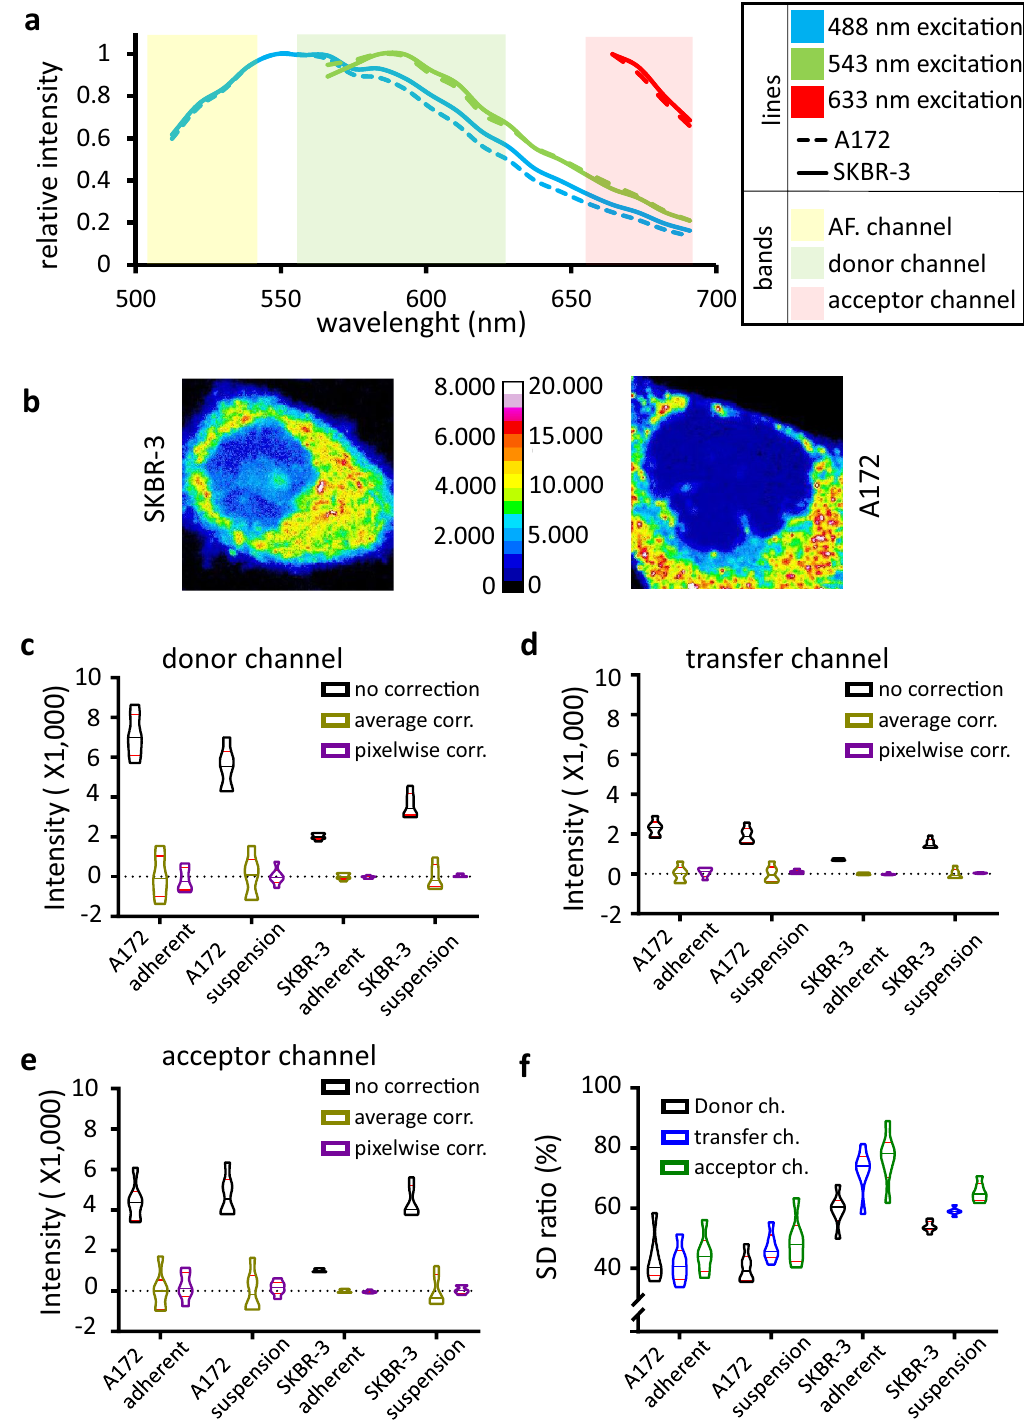
Figure 1. Characterization of cellular autofluorescence and different autofluorescence correction methods. ( a ) Autofluorescence emission spectra of A172 and SKBR-3 cells measured with a spectral detector upon 488; 543 and 633 nm excitation. The typical emission channels of a FRET measurement are represented as colored bands. ( b ) Autofluorescence intensity distribution of an SKBR-3 and an A172 cell. ( c – e ) Autofluorescence contribution to the donor, transfer and acceptor channels of a typical FRET measurement before correction, after correction with average autofluorescence and after pixel-by-pixel correction, demonstrated using non-labeled cells grown on a coverslip, as well as cells mounted in suspension after trypsinization. Average emission intensities of 6 independent samples in arbitary units as violin plots ( c donor channel, d transfer channel, e acceptor channel). ( f ) Ratio of the standard deviations of pixel-by-pixel corrected to average corrected autofluorescence distributions from data in panels ( c – e